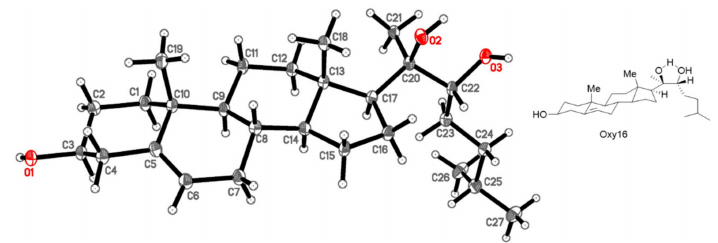
Figure 3. Ortep representation of Oxy16 in the solid